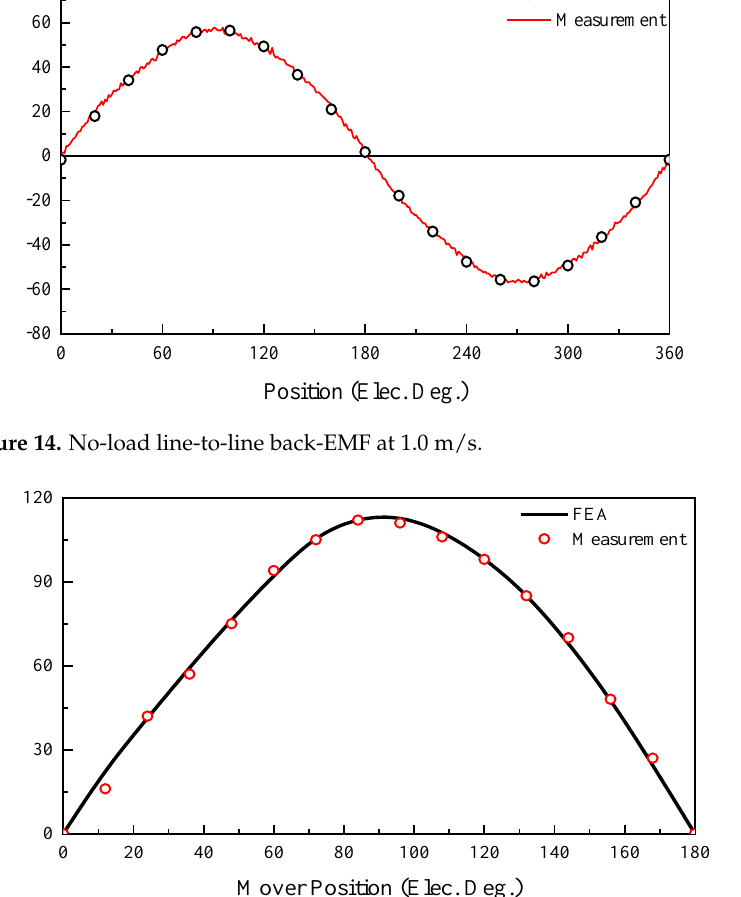
Mover Position (Elec. Deg.) Figure 15. Static thrust waveform comparison under DC current loading of 2A between phases U and V. Figure 15. Static thrust waveform comparison under DC current loading of 2A between phases U and V. Figure 15. Static thrust waveform comparison under DC current loading of 2A between phases U and V. Figure 15. Static thrust waveform comparison under DC current loading of 2A between phases U and V.